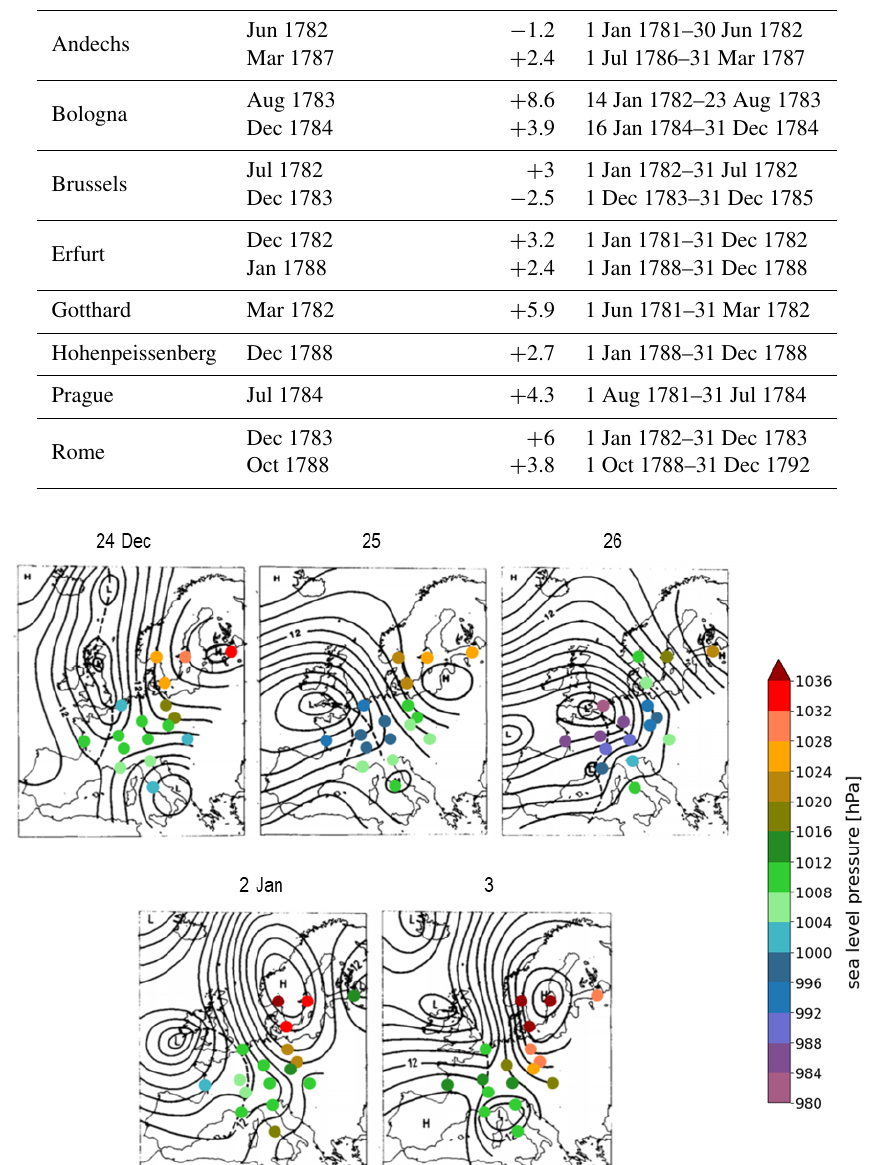
Figure 7. Kington’s hand-drawn synoptic maps showing the storms as they moved over Europe covering the days from 23 to 26 Decem- ber 1783 and from 2 to 3 January 1784. Isobars are drawn at 4hPa intervals, and “12” denotes the 1012hPa isobar; dashed lines indicate fronts. Coloured points represent SMP pressure observations in hectopascals reduced to sea level from 17 selected stations. The figure is adapted from Kington (1988, pp. 99–100) and reproduced with permission from Cambridge University Press through